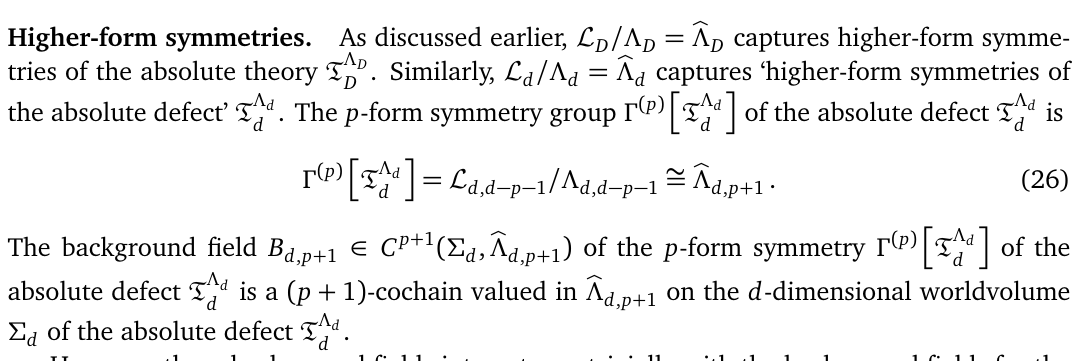
Λ d of the boundary condition B d